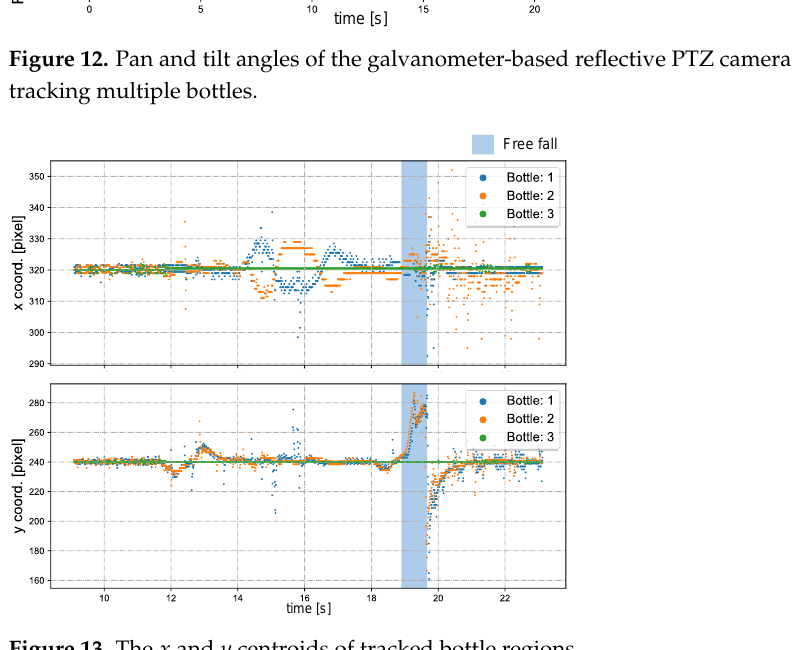
Figure 13. The x and y centroids of tracked bottle regions.